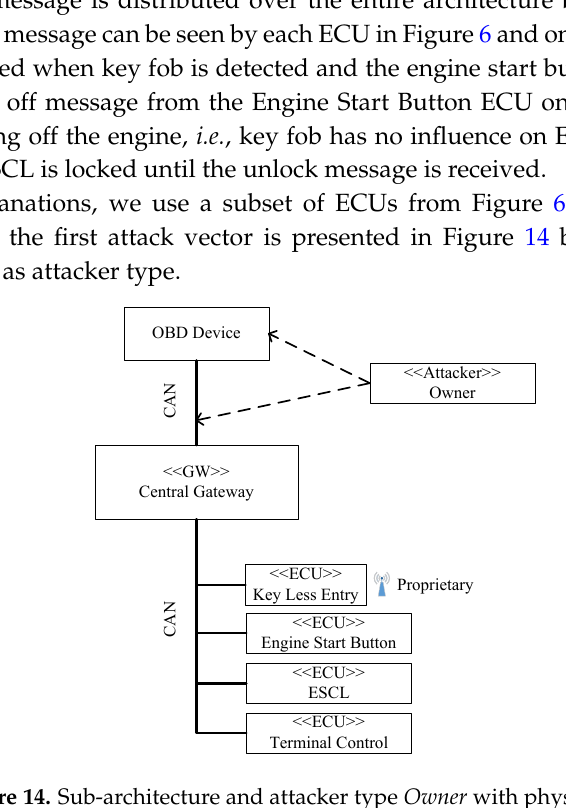
Figure 14. Sub-architecture and attacker type Owner with physical access.